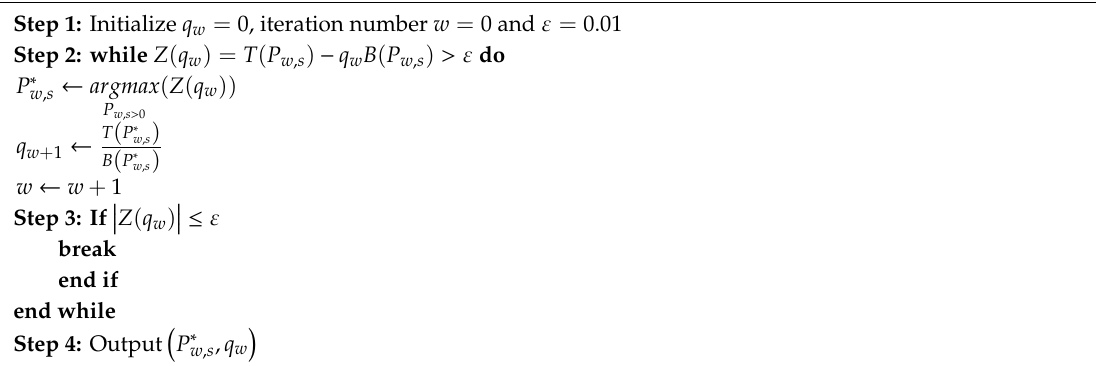
Algorithm 2. Dinkelbach method for energy e ffi ciency